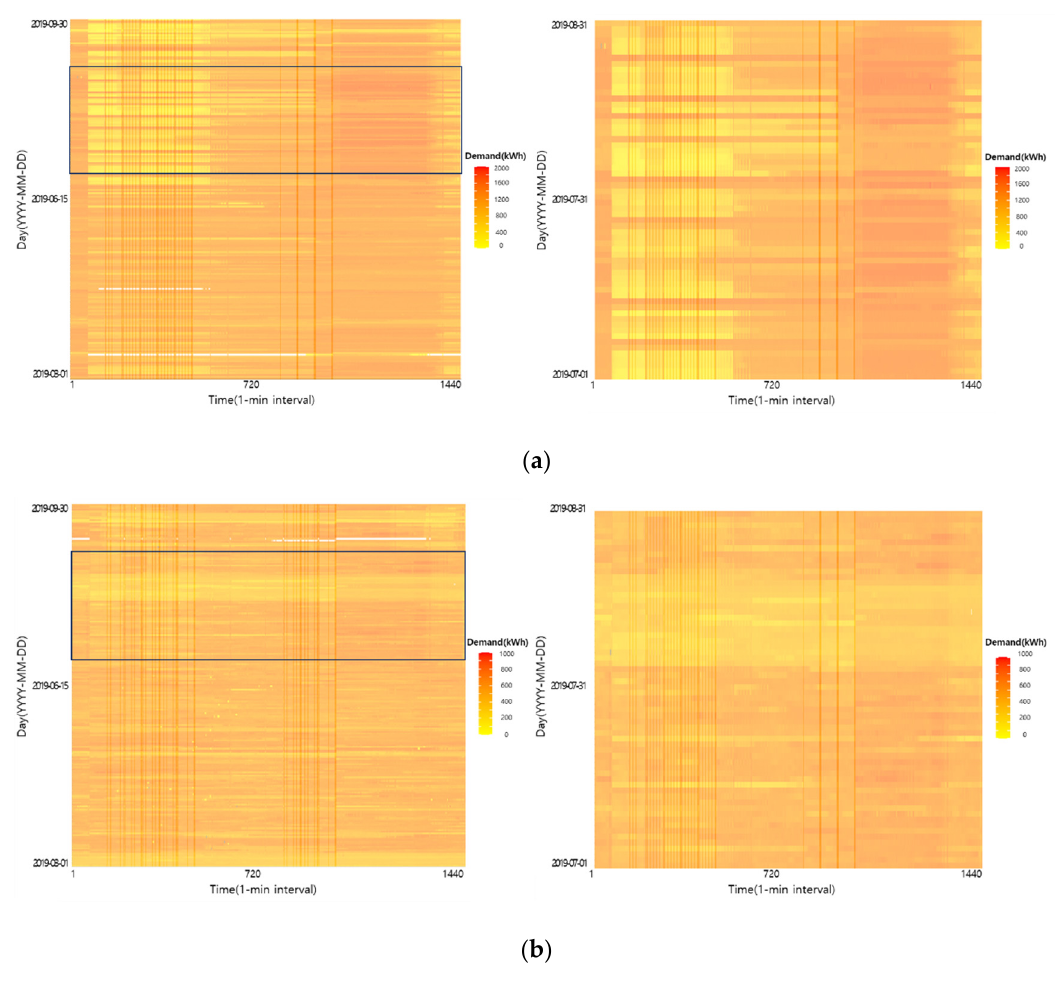
Figure 3. Electricity demand heat map (1 March–30 September 2019, 1 July–31 August 2019): ( a ) Cement #1, ( b ) Cement #2.